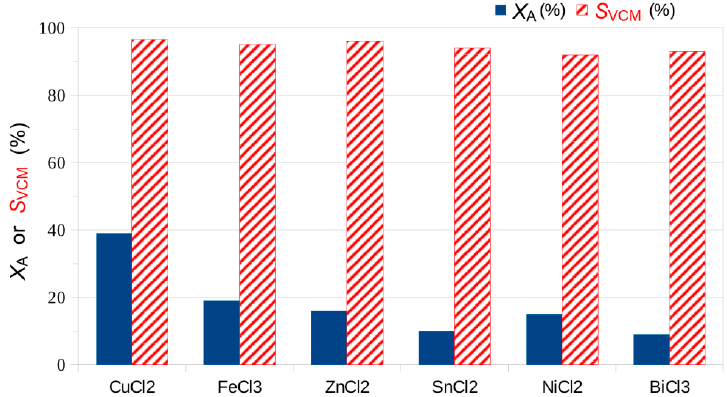
Figure 6. Acetylene conversion rate and VCM selectivity of different metal chlorides, as the reaction medium. Reaction temperature 140 ◦ C, C 2 H 2 GHSV = 370 h − 1 , V HCl :V C2H2 = 1.2, using [PrMIm]Cl as the reaction medium. Reaction temperature 140 °C, C 2 H 2 GHSV = 370 h − 1 , V HCl :V C2H2 = 1.2, and concentration of metal chloride 0.10 mol L − 1 . and concentration of metal chloride 0.10 mol L − 1